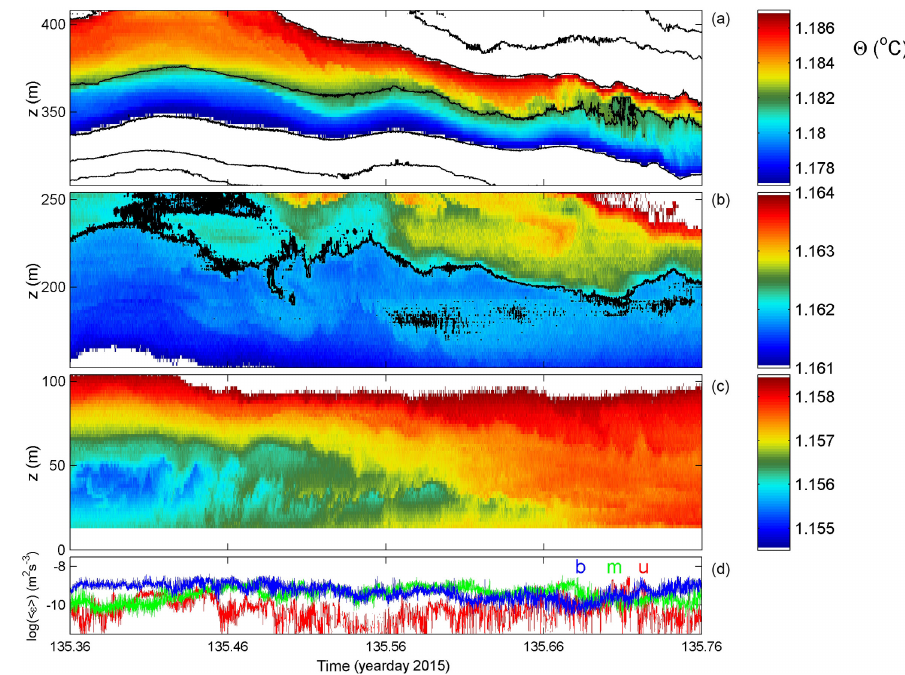
Figure 10. As Fig. 4, but associated with Fig. 9 and using different colour